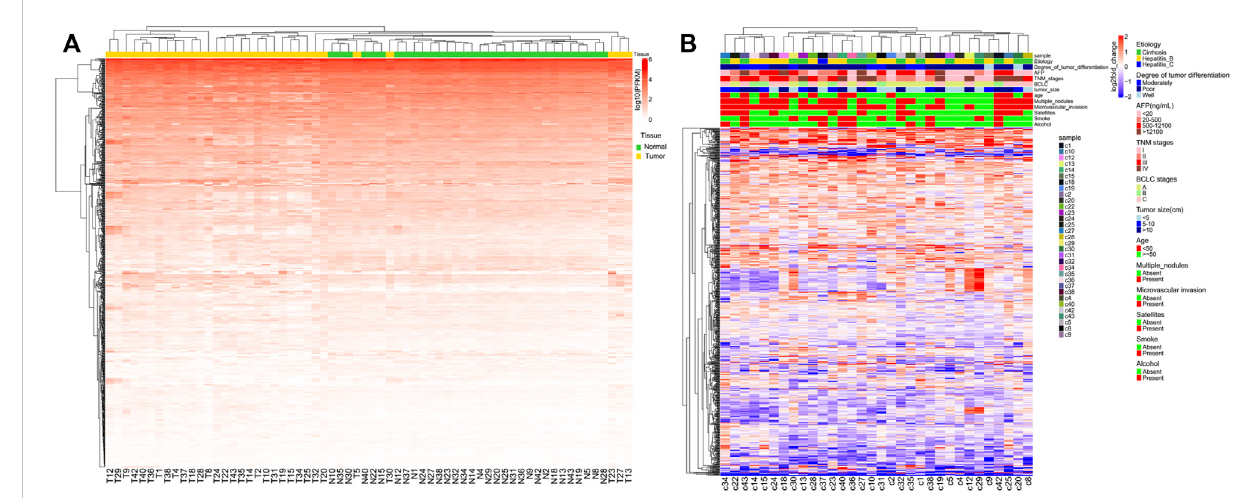
FIGURE 1 UnsupervisedhierarchicalclusteringwithcompletelinkageandSpearmancorrelationdepicting (A) globalmiRNAexpressioninallHCCpatientsand (B) global log2fold_changes of each miRNA and each HCC